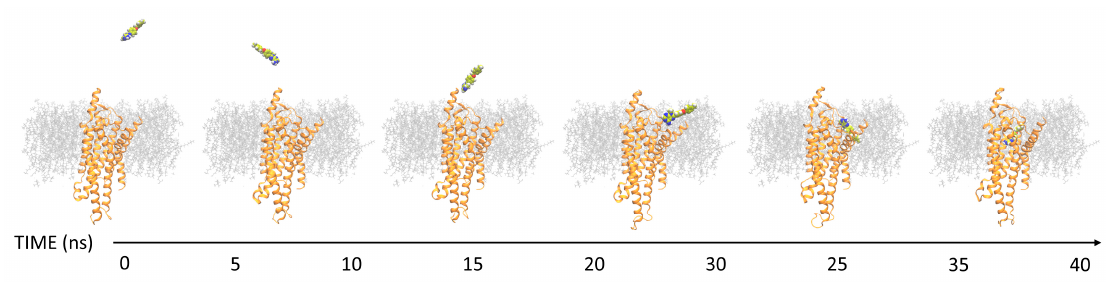
Figure 3. Representation of a binding event sampled by a supervised molecular dynamics (SuMD) simulation. After each reported step, the distance between the ligand and the binding site decreases. In less than (merged) 50 ns, a binding event was